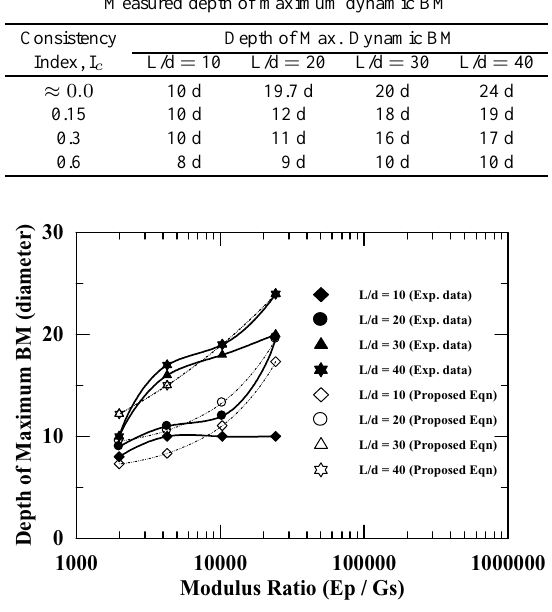
Fig. 16. Comparison the measured and predicted (using proposed equations) depth of maximum dynamic